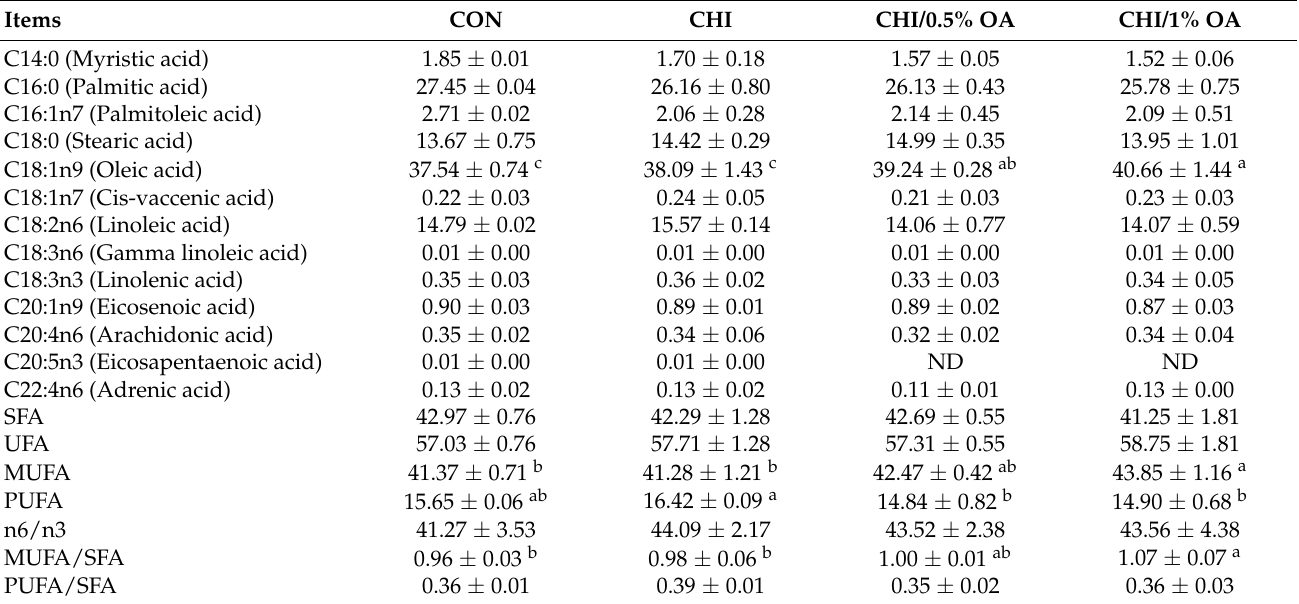
Table 1. Effects of chitosan/oleic acid coating on fatty acid profiles of pork after one day of